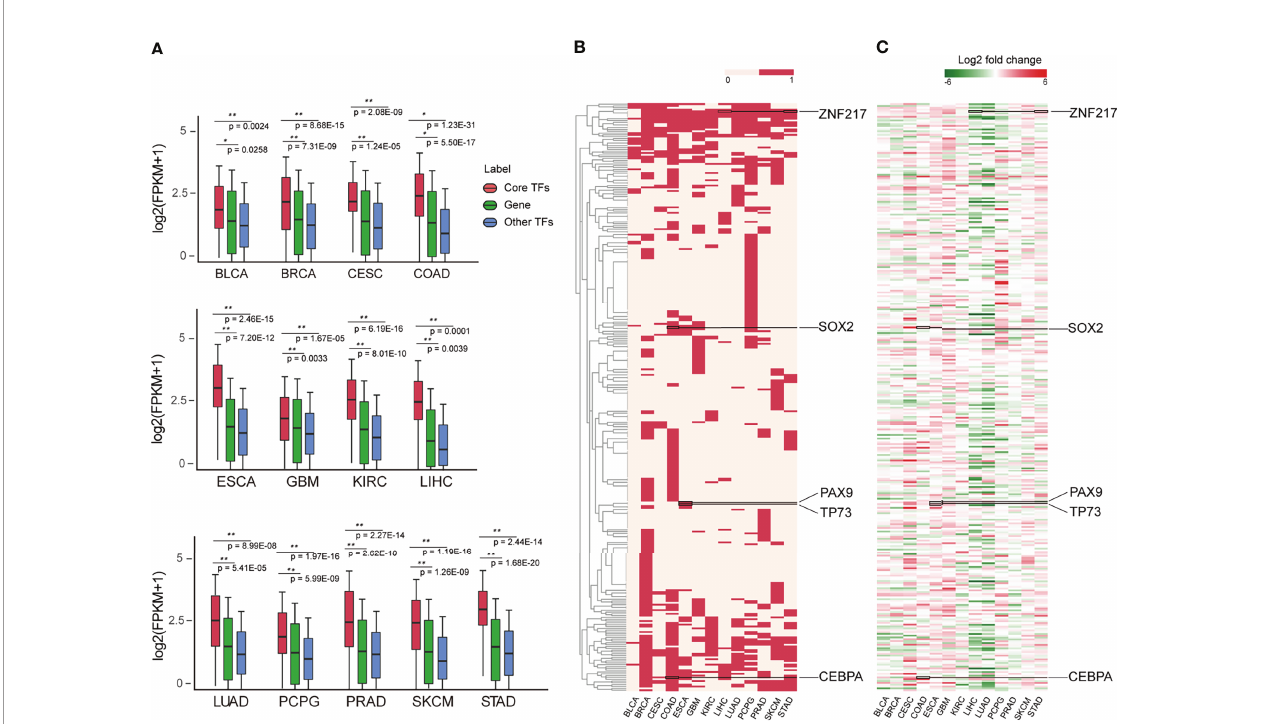
FIGURE 4 | Landscape of core TFs in 13 cancers. (A) Box plots show the expression level on the log2 scale (FPKM+1) of core TFs, common genes and other TFs in 13 cancer types. P-values quantifying the difference between two sets were calculated using the Wilcoxon test. (B) Clustering of core TFs in different cancer types. Red represents the presence of TFs in the CRC of the cancer type. (C) Clustering of differently expressed core TFs in cancer types. The values were calculated by log 2 (fold change) between control and cancer